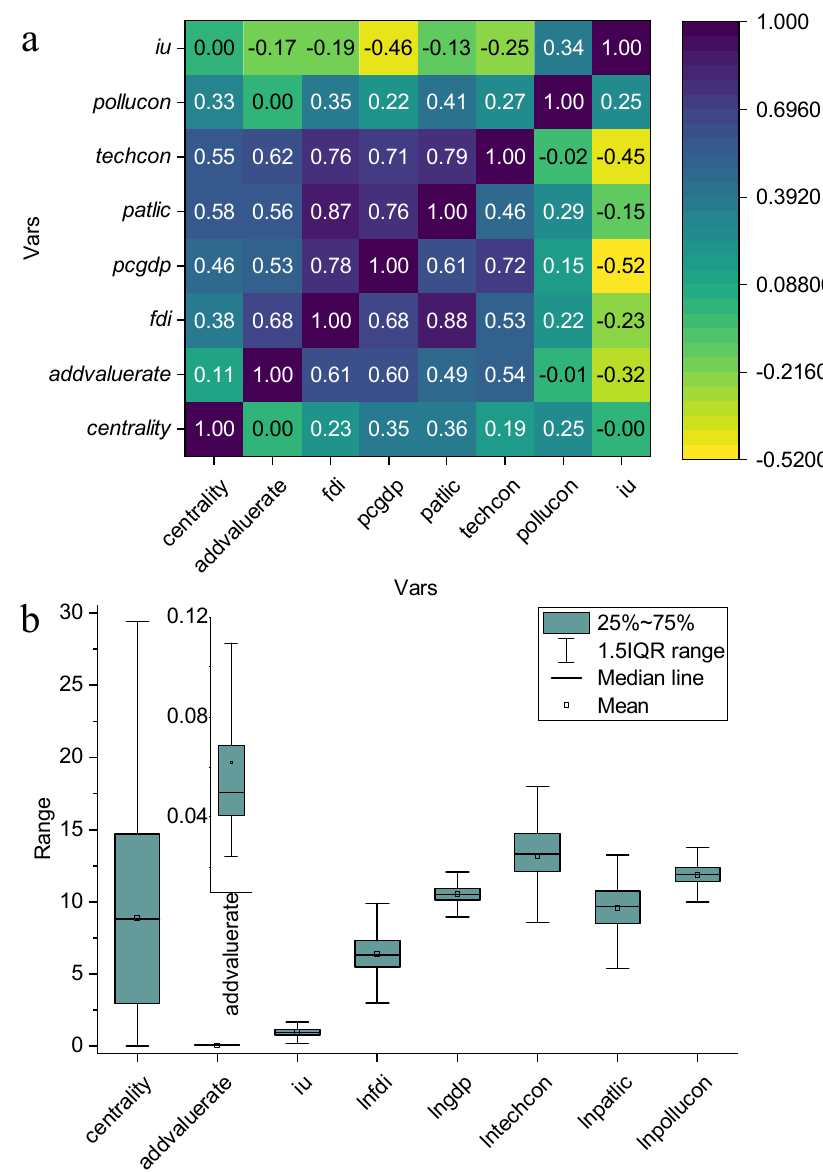
Figure 4. Descriptive statistics of the main changes. Notes: ( a ), correlation coefficient distribution of the core variables; ( b ), box plot of the core variables. These diagrams were created by the author using Origin Pro 2022.